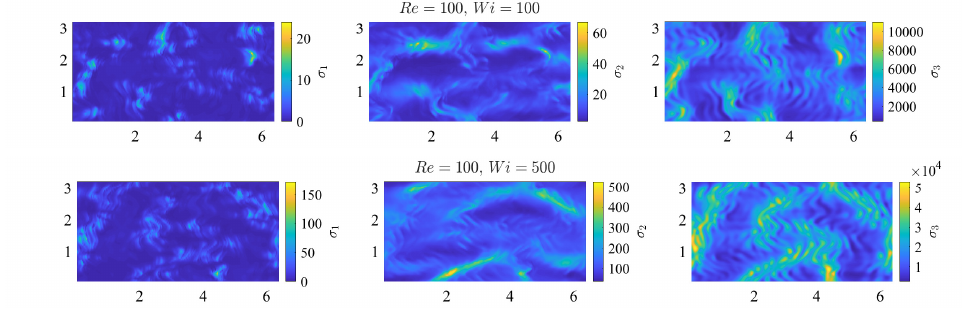
Figure 16. Contour of eigenvalues in the x – z plane at channel center y = δ for Wi = 100 ( top ) and Wi = 500 ( bottom ), fixed at Re =